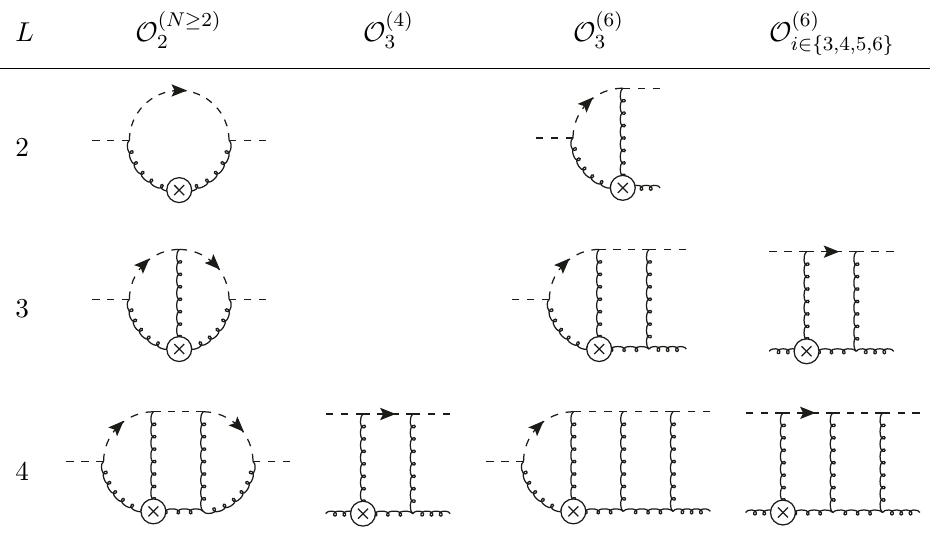
Table 7 . In the L th row the table gives examples of diagrams containing a ghost-anti-ghost pair and gluons whose UV-counterterms determine the mixing of O ( N ) into unphysical operators O ( N ∈{ 2 , 4 , 6 } ) as required for the computation of the L -loop contribution to Z ( N ∈{ 2 , 4 , 6 } ) ,L